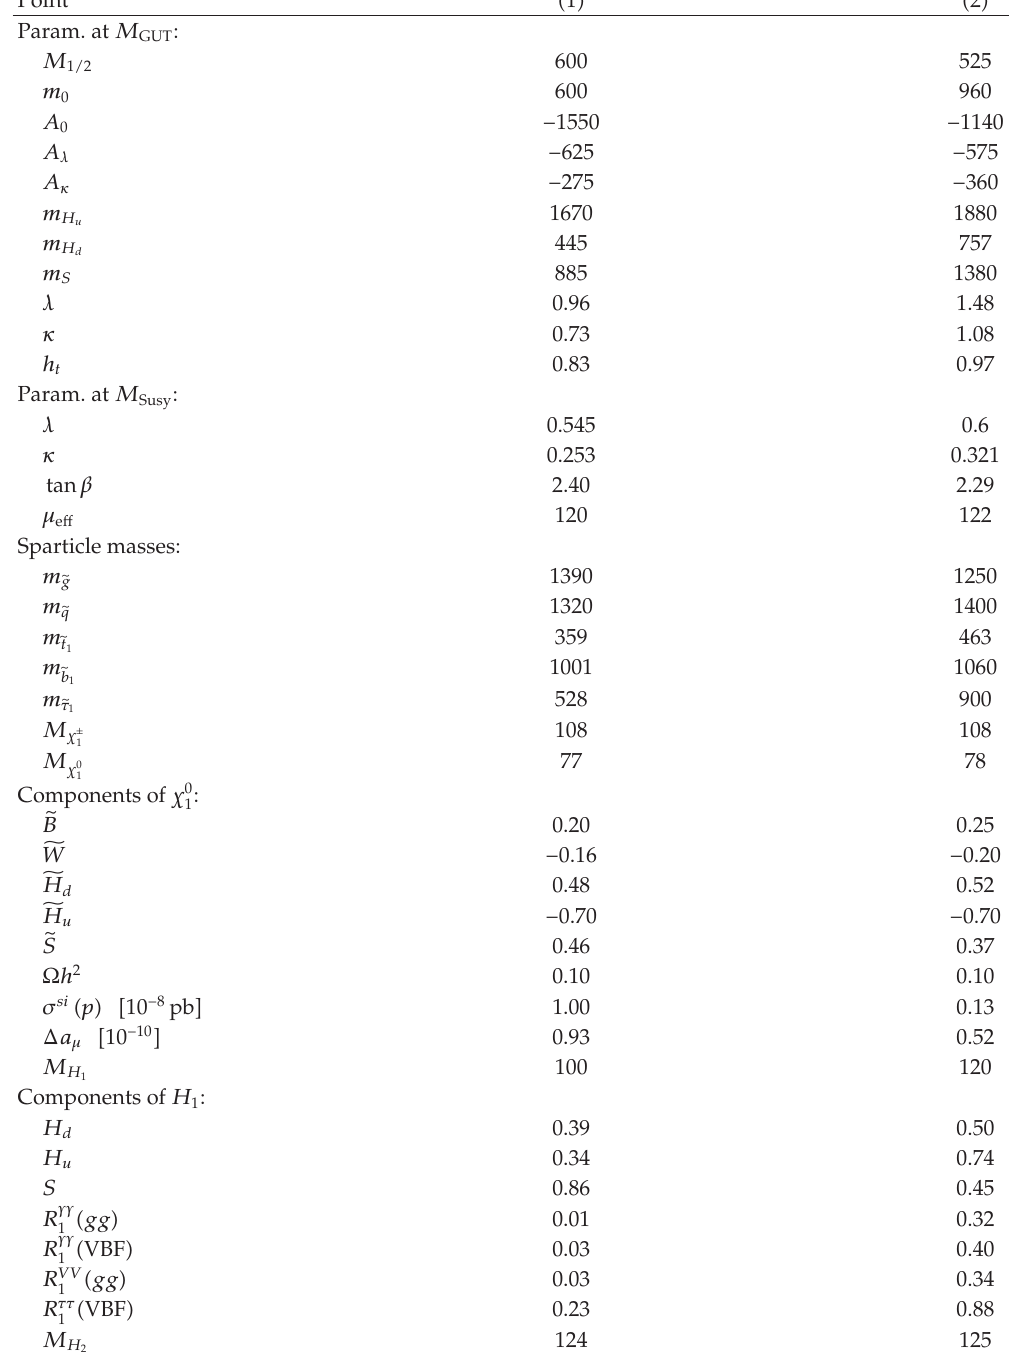
Table 1: Properties of two benchmark points corresponding to di ff erent values of M H parameters are given in GeV. The components of χ 0 that their squares sum up to 1. The Susy contributions Δ a μ to the muon anomalous magnetic moment are those given by NMSSMTools without any theoretical